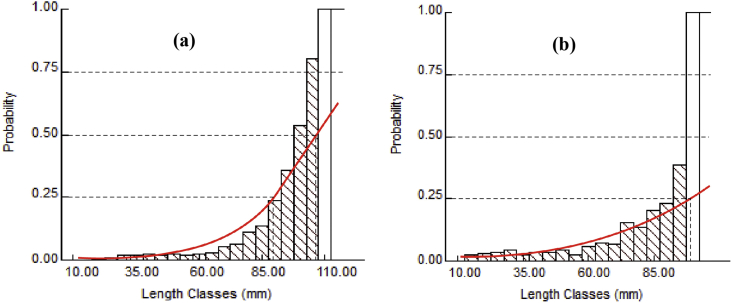
Probability of capture based on length (CW) classes of (a) male and (b) female S. olivacea.